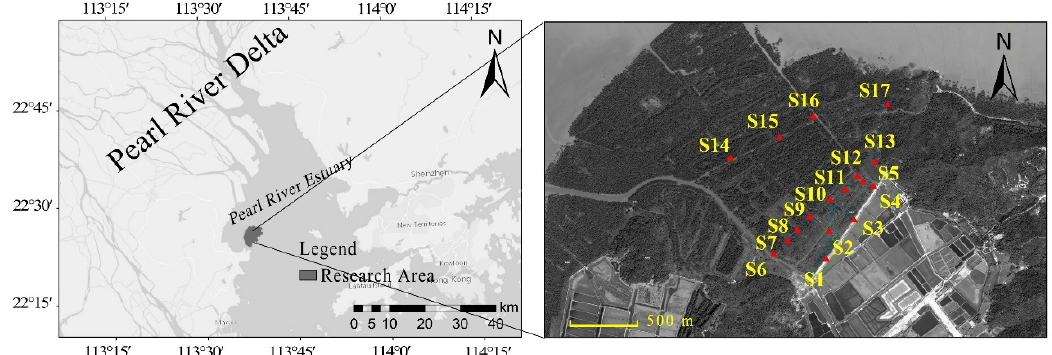
Figure 1. Maps showing the geographical location of the study area within the Pearl River estuary and the sampling locations within the study area